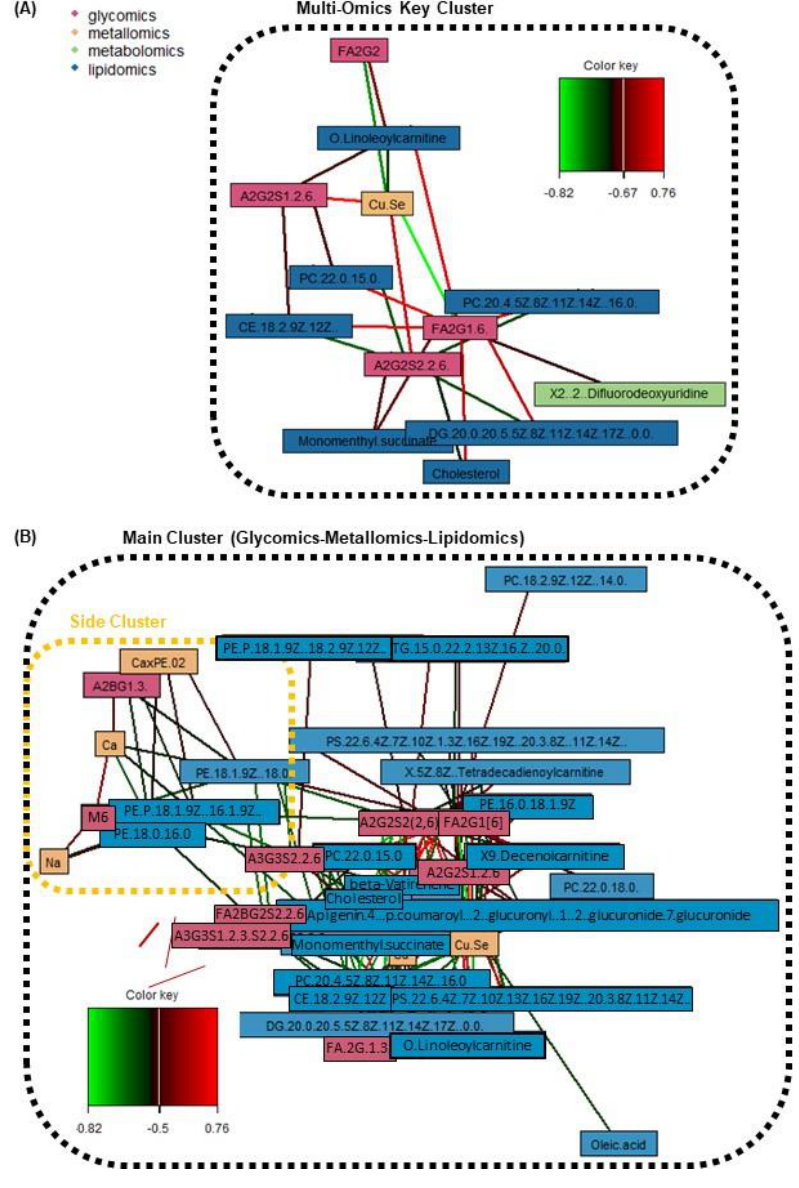
Figure 4. Relevance network plots of significant omics features from the discrimination of AMI vs. healthy patients, displaying ( A ) key cluster amongst all four omics with strong correlations between features ( r ≥ 0.67; p -value < 0.05), and ( B ) tri-omics (glycomics + metallomics + lipidomics) correlations ( r ≥ 0.5; p -value < 0.05). The color key indicates the correlation coefficient values annotated by the connection lines between variables. Red colored connection lines denote positive correlations, while green colored connection lines denote negative correlations between variables. The intensity of the colors is scaled according to the magnitude of the correlation coefficient values.